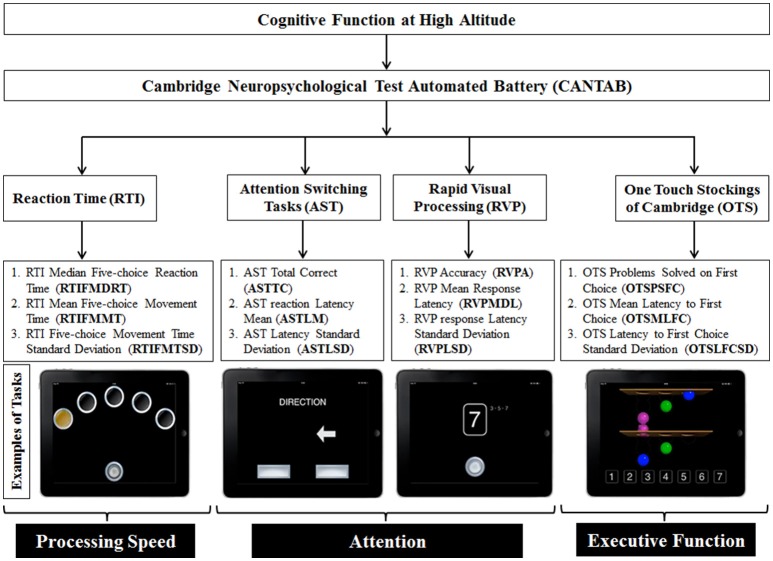
CANTAB battery tests that were incorporated in the study. Reaction time (RTI), attention (AST and RVP) and executive functions (OTS) have been tested. The red boxes indicate the grouping classification of the test batteries i.e. reaction time, attention and executive function. The bottom part of the figure illustrates representative example pictures of respective CANTAB battery/task used in the study (Cambridge Cognition, 1994) from left to right: RTI, AST, RVP, and OTS.